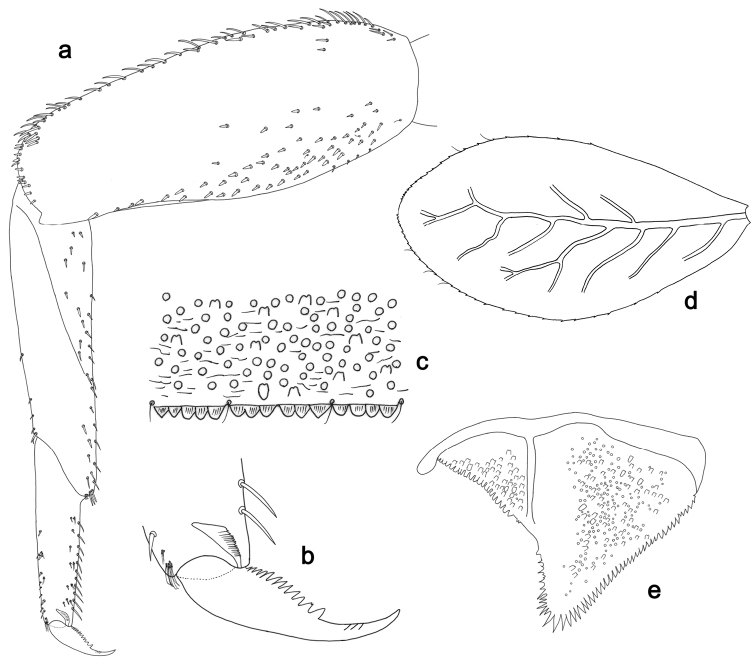
Labiobaetisjanae sp. n., larva morphology: aForelegb Fore claw cTergum IV d Gill IV eParaproct.